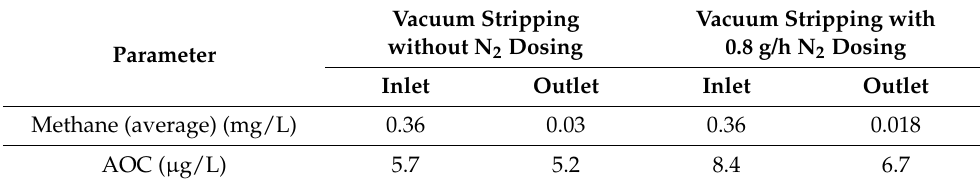
Table 1. Concentrations of assimilable organic carbon (AOC) in water sampled in pilot studies with different methane